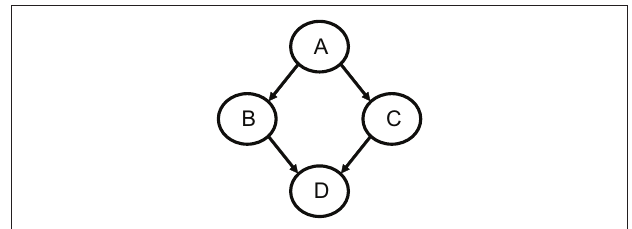
FiGure 4 | A DAG with four nodes (among them jobs B and C run in